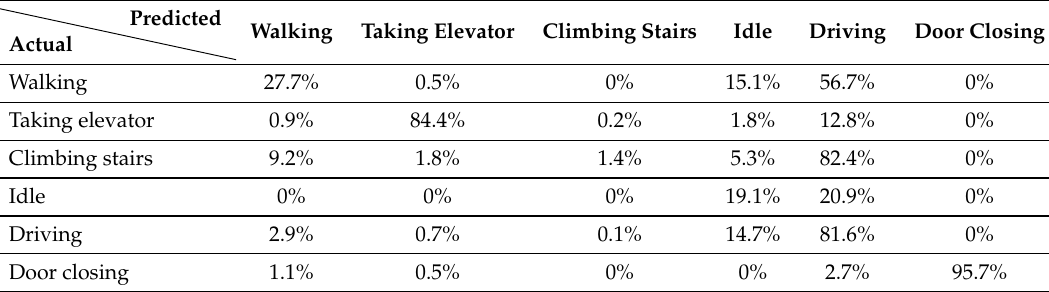
Table 8. Confusion matrix for the MBD